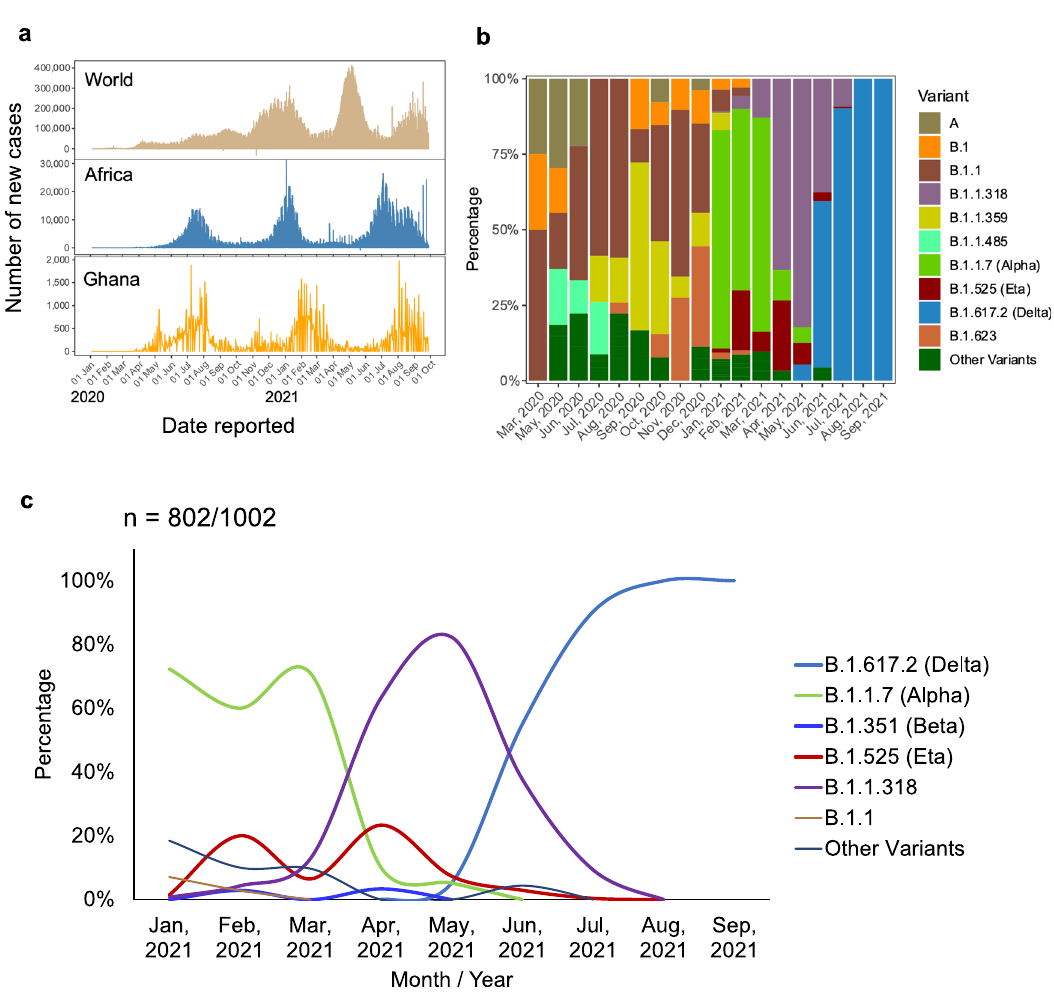
Fig. 2 Trends in the variant epidemiology in Ghana. a Trends of COVD-19 in the World, Africa and Ghana, which indicates the date reported against the number of new cases. This shows the number of con fi rmed COVID-19 cases recorded daily in the World, Africa, and Ghana from January 2020 to October 2021. The data were obtained from World Health Organisation (https://covid19.who.int/WHO-COVID-19-global-data.csv). b Trends in prevalence of major variants circulating in Ghana from March 2020 to September 2021. The Y -axis shows the percentage distribution ( n = 1002/1123) of various variants including VOCs across the various months ( X -axis) while the lineages are represented by different colours. c Impact of emergence of variants of concern (VOCs) on dynamics of viral lineages dominating community transmission in Ghana in 2021